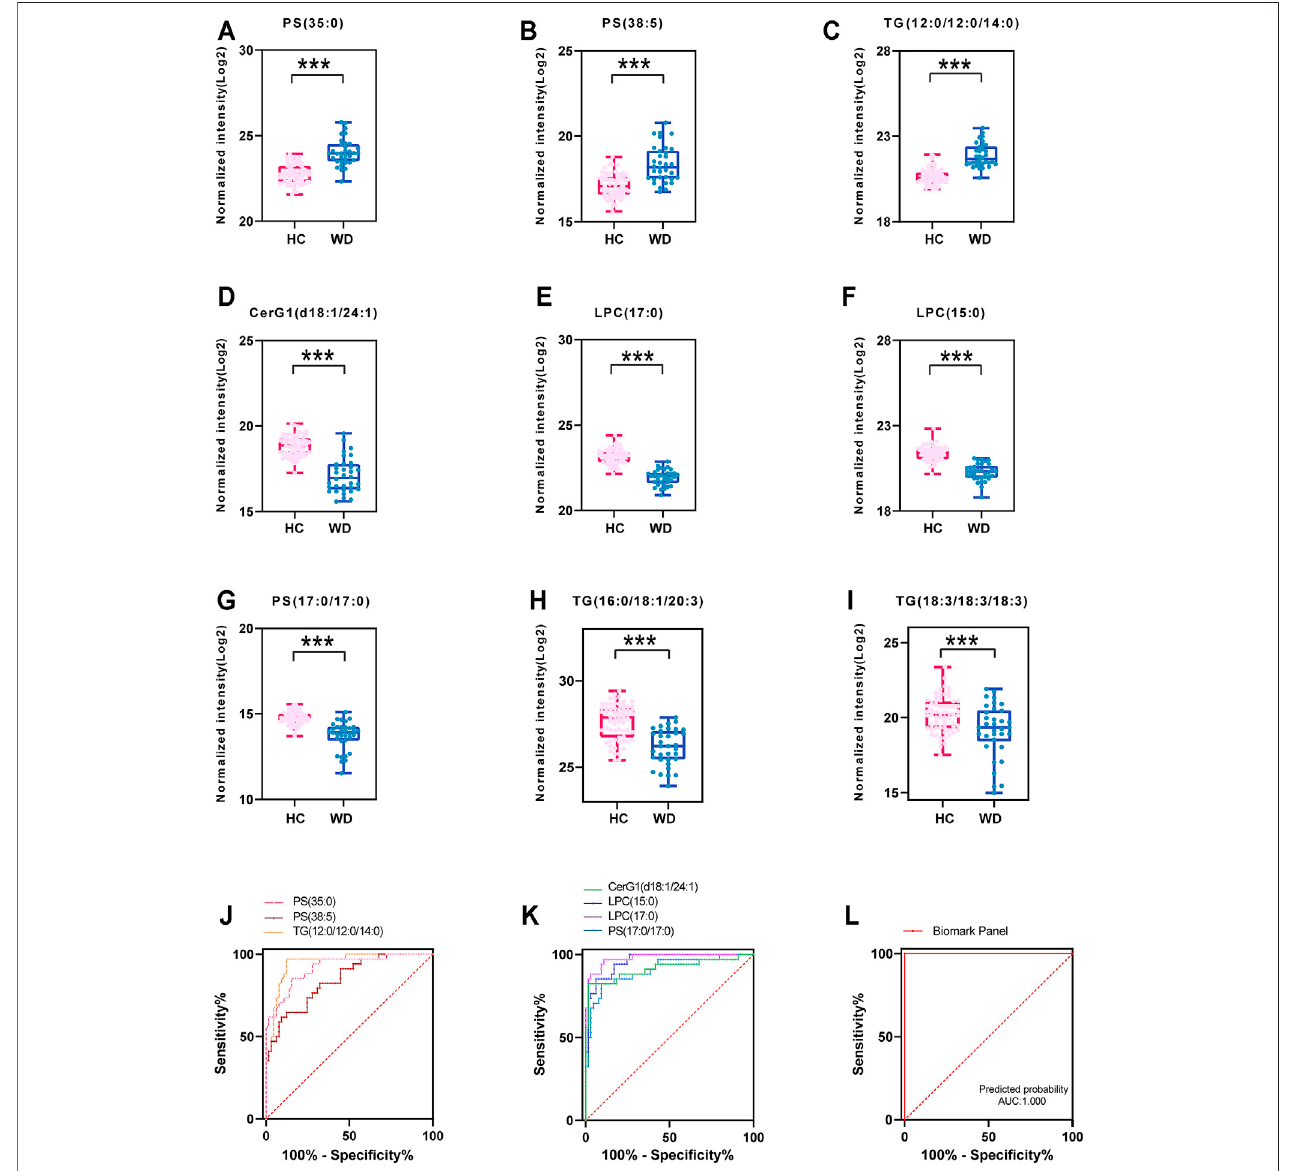
FIGURE 5 | Fitting prediction of WD biomarkers. (A – G) Relative concentration of signi fi cantly differentially abundant metabolites screened by LASSO in WD and HC. (H – I) Relative unsaturated TG concentration ofsigni fi cantlydifferentially abundant metabolites inWD and HC. (J – K) ROCcurve analysis ofincreased metabolites in WD and HC. (L) ROC curve analysis of the biomarker panel in WD and HC.